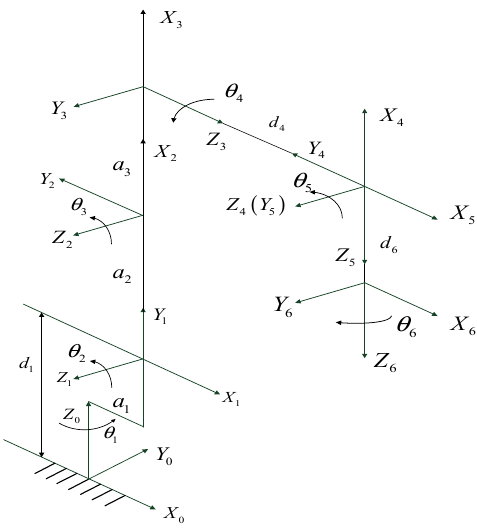
Figure 7. The link coordinate frame of the SR4C robot.